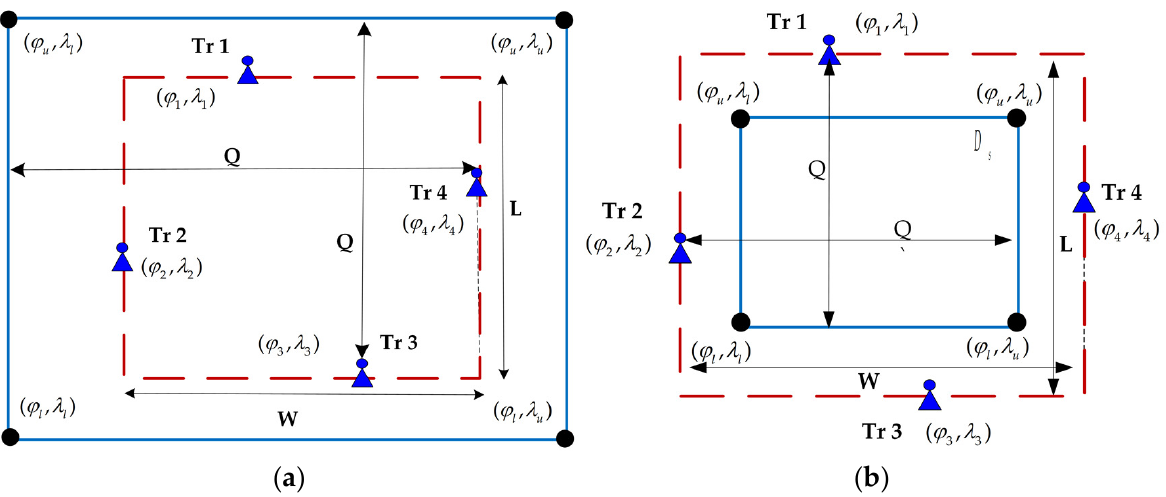
Figure 6. Shrinking diagram, ( a ) When Q > W , Q > L , the range of D s . ( b ) When Q < W , Q < L , the range of D s